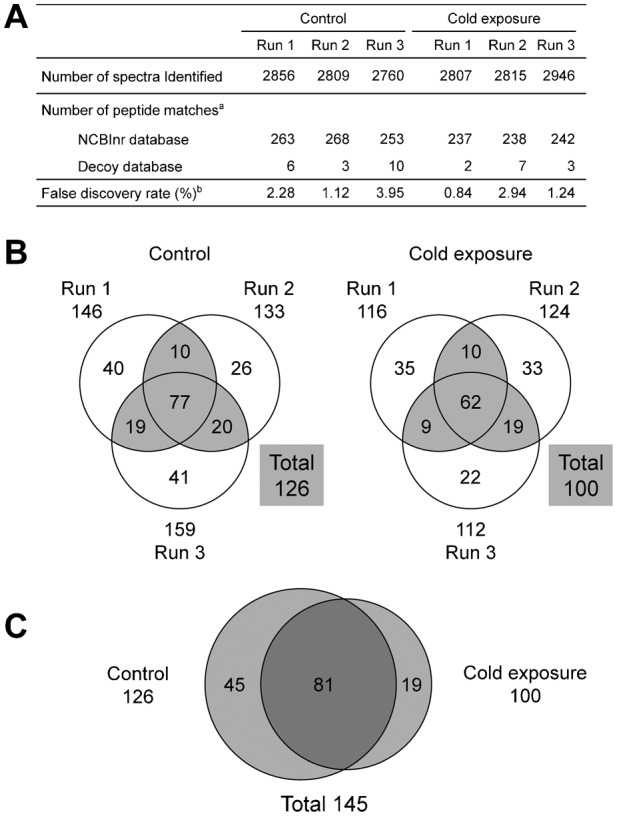
Outlines of MASCOT MS/MS ions search. (A) Summary of MASCOT peptide identification in each search. aPeptide matches above identity threshold (P<0.05); bFDR  =  decoy hits/NCBInr hits. (B) Venn diagrams of identified proteins in individual searches. Proteins identified in at least two of the triplicate runs are highlighted in grey. (C) Comparison of valid identified proteins differentially expressed between the control and cold-exposure conditions. Proteins identified at least twice were compared (126 proteins from the control group and 100 proteins from the cold-exposure group); 81 proteins overlapped between both groups.